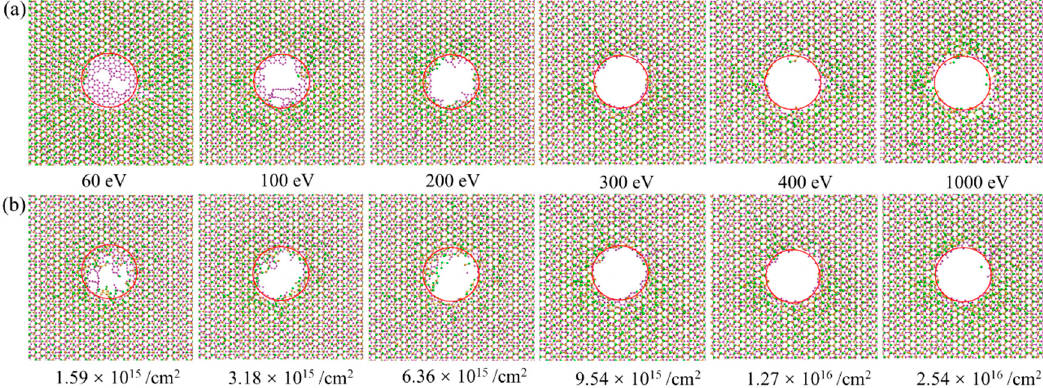
Figure 6. Configurations of the M/G heterostructure under ion irradiation with different ion energies and ion doses. ( a ) The influence of ion energy under a constant ion dose of 1.27 × 10 16 /cm 2 . ( b ) The influence of ion dose under a constant ion energy of 300 eV. The red colored circle is used to indicate the irradiation area.